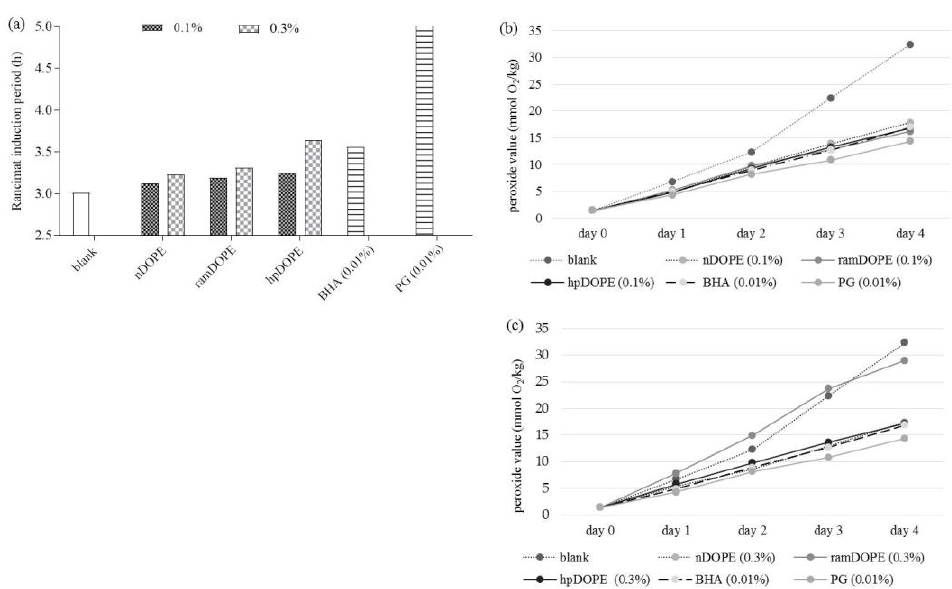
Figure 1. Antioxidant activity of DOPE in oil. ( a ): Rancimat induction period; ( b ): Peroxide value of safflower oil during storage with 0.1% DOPE; ( c ): Peroxide value of safflower oil during storage with 0.3% DOPE. nDOPE-native dry olive pomace extract; hpDOPE-extract prepared with hydroxypropyl- β -cyclodextrin; ramDOPE-extract prepared with randomly methylated β -cyclodextrin; BHA: Butylhydroxyanisol; PG: Propyl-gallate.